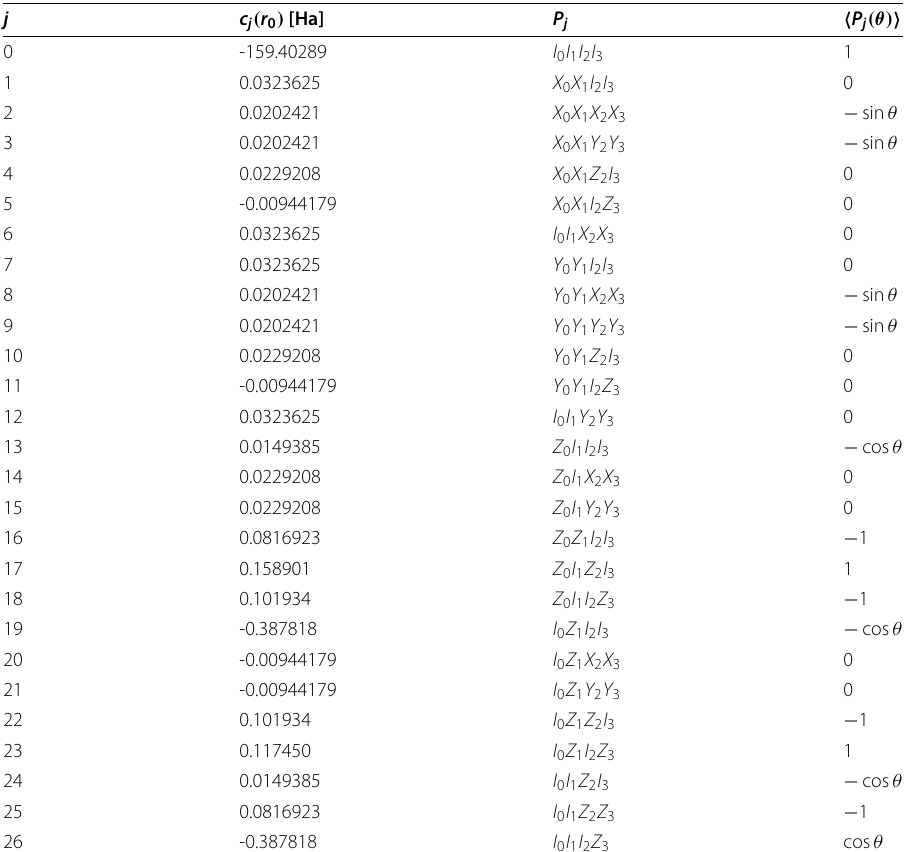
Table 1 Four-spin representation of the two-electron, NaH Hamiltonian and expectation value of the Pauli strings with respect to the UCCD ansatz for r = 1.91438Å j c j ( r 0 ) [Ha] P j (cid:2) P j (θ)